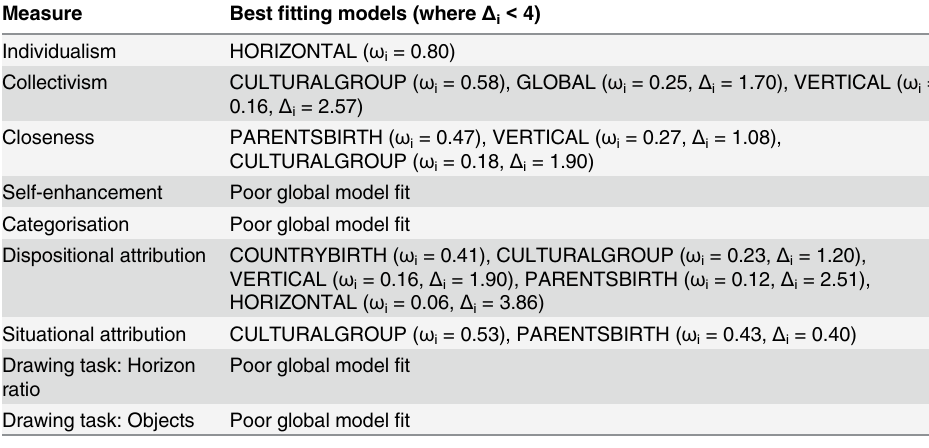
Table 5. Best-fitting predicted models. Δ i = difference in AIC c from best-fitting model; ω i = Akaike weight. See text and Table 3 for model specifications. All models with Δ i < 4 are listed. Δ i for best-fitting models is always 0 and so not shown. For four measures (self-enhancement, categorisation, horizon ratio and addi- tional objects), the global model did not fit the data so model comparison was not possible. See S1 Table for full model comparison